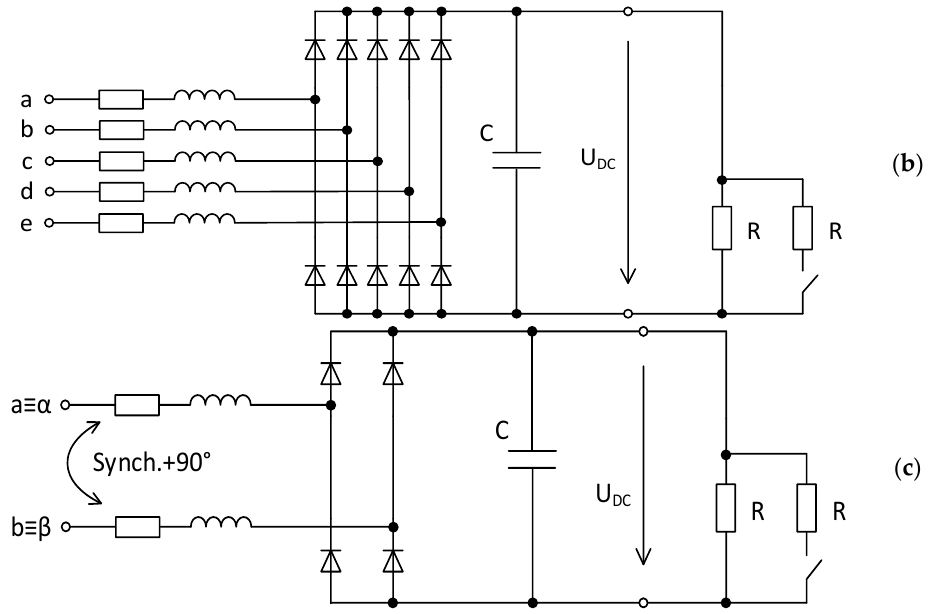
Figure 13. The basic scheme of the considered systems: 3-phase ( a ), 5-phase ( b ), and 2-phase ( c ).